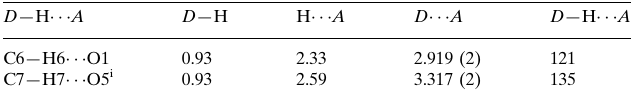
Hydrogen-bond geometry (A˚ , (cid:1)